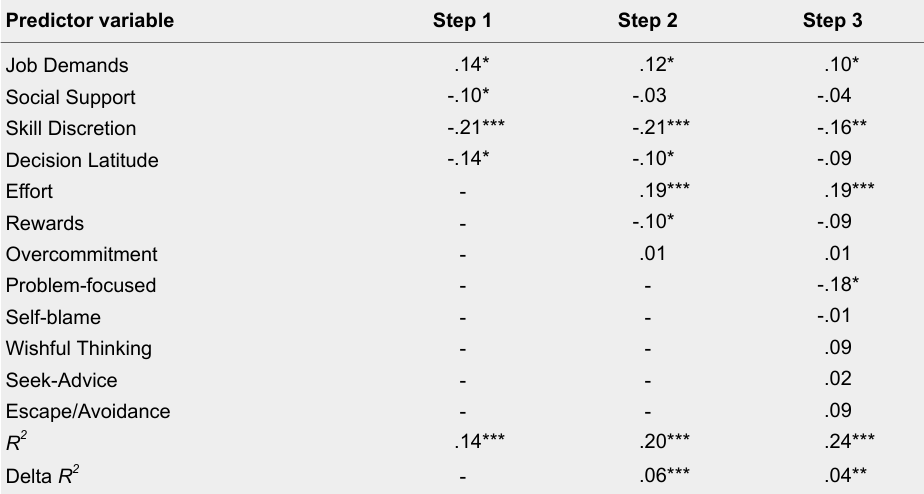
Hierarchical Multiple Regression: DCS, ERI and Coping Variables Against Depression (β values) Predictor variable